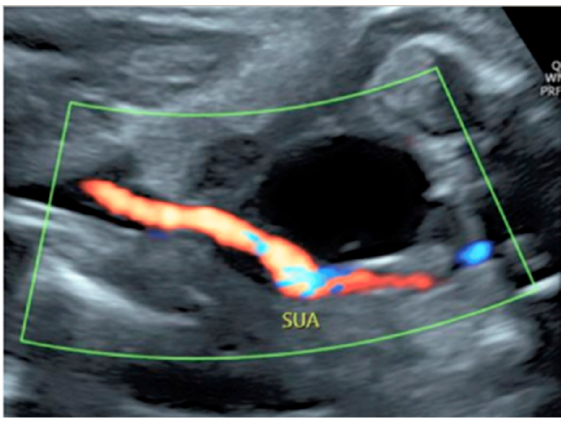
Figure 30. Doppler ultrasound showing a single umbilical artery (SUA) coursing along the bladder.